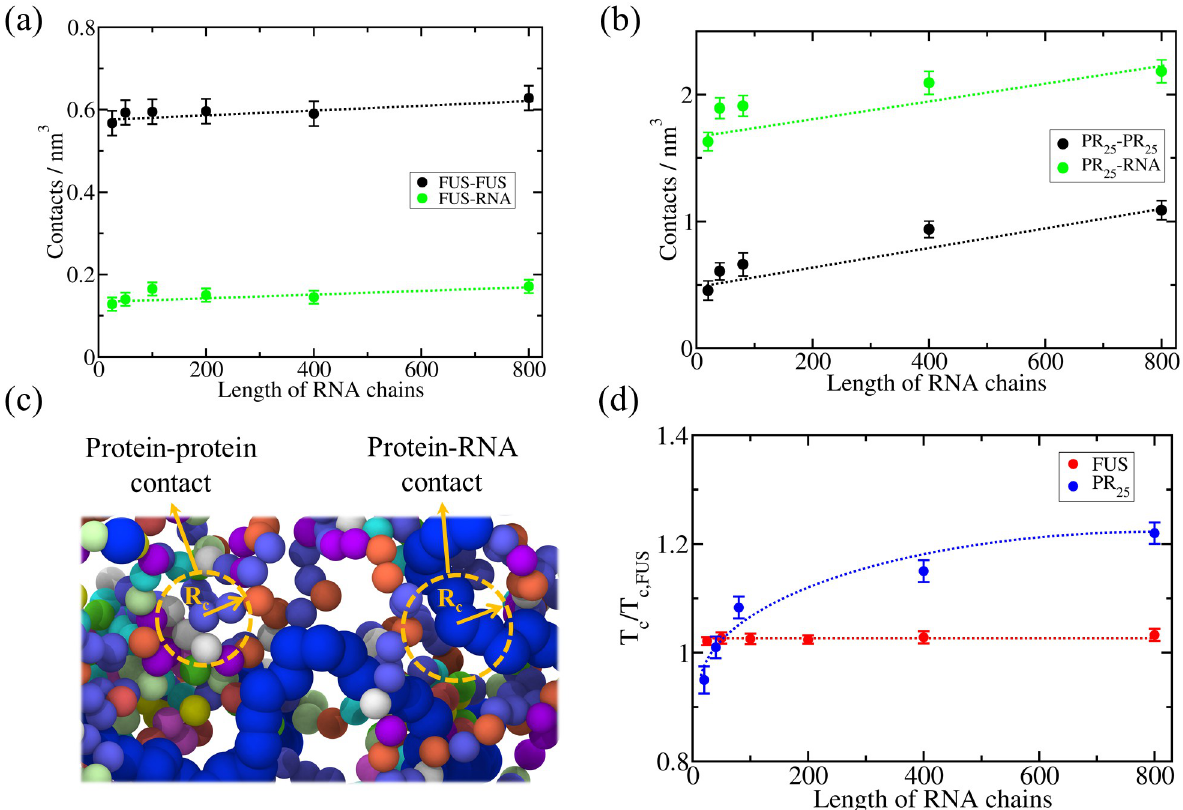
Fig 4. Density of LLPS-stabilizing intermolecular contacts within condensates as a function of RNA length plotted separately for protein–protein interactions (black symbols) and protein–RNA interactions (green symbols) for FUS–polyU (a) and PR 25 –polyU mixtures (b). The temperature at which the intermolecular contacts were computed was T / T c,FUS = 0.99 for FUS–RNA systems, and T / T c,FUS = 0.85 for PR 25 –RNA mixtures. Error bars depict the computed standard deviation in the number of molecular contacts. (c) Representative snapshot of a bulk FUS–polyU condensate to illustrate the employed cut-off distance ( R c ) criterion to identify protein--protein and protein--RNA contacts. The same color code described in Fig 1 applies here. (d) Critical temperature versus RNA length for FUS–RNA (red) and PR 25 –RNA (blue) systems. The RNA/protein mass ratio of all systems was kept constant at 0.096 for FUS–RNA systems and at 1.20 for PR 25 –RNA